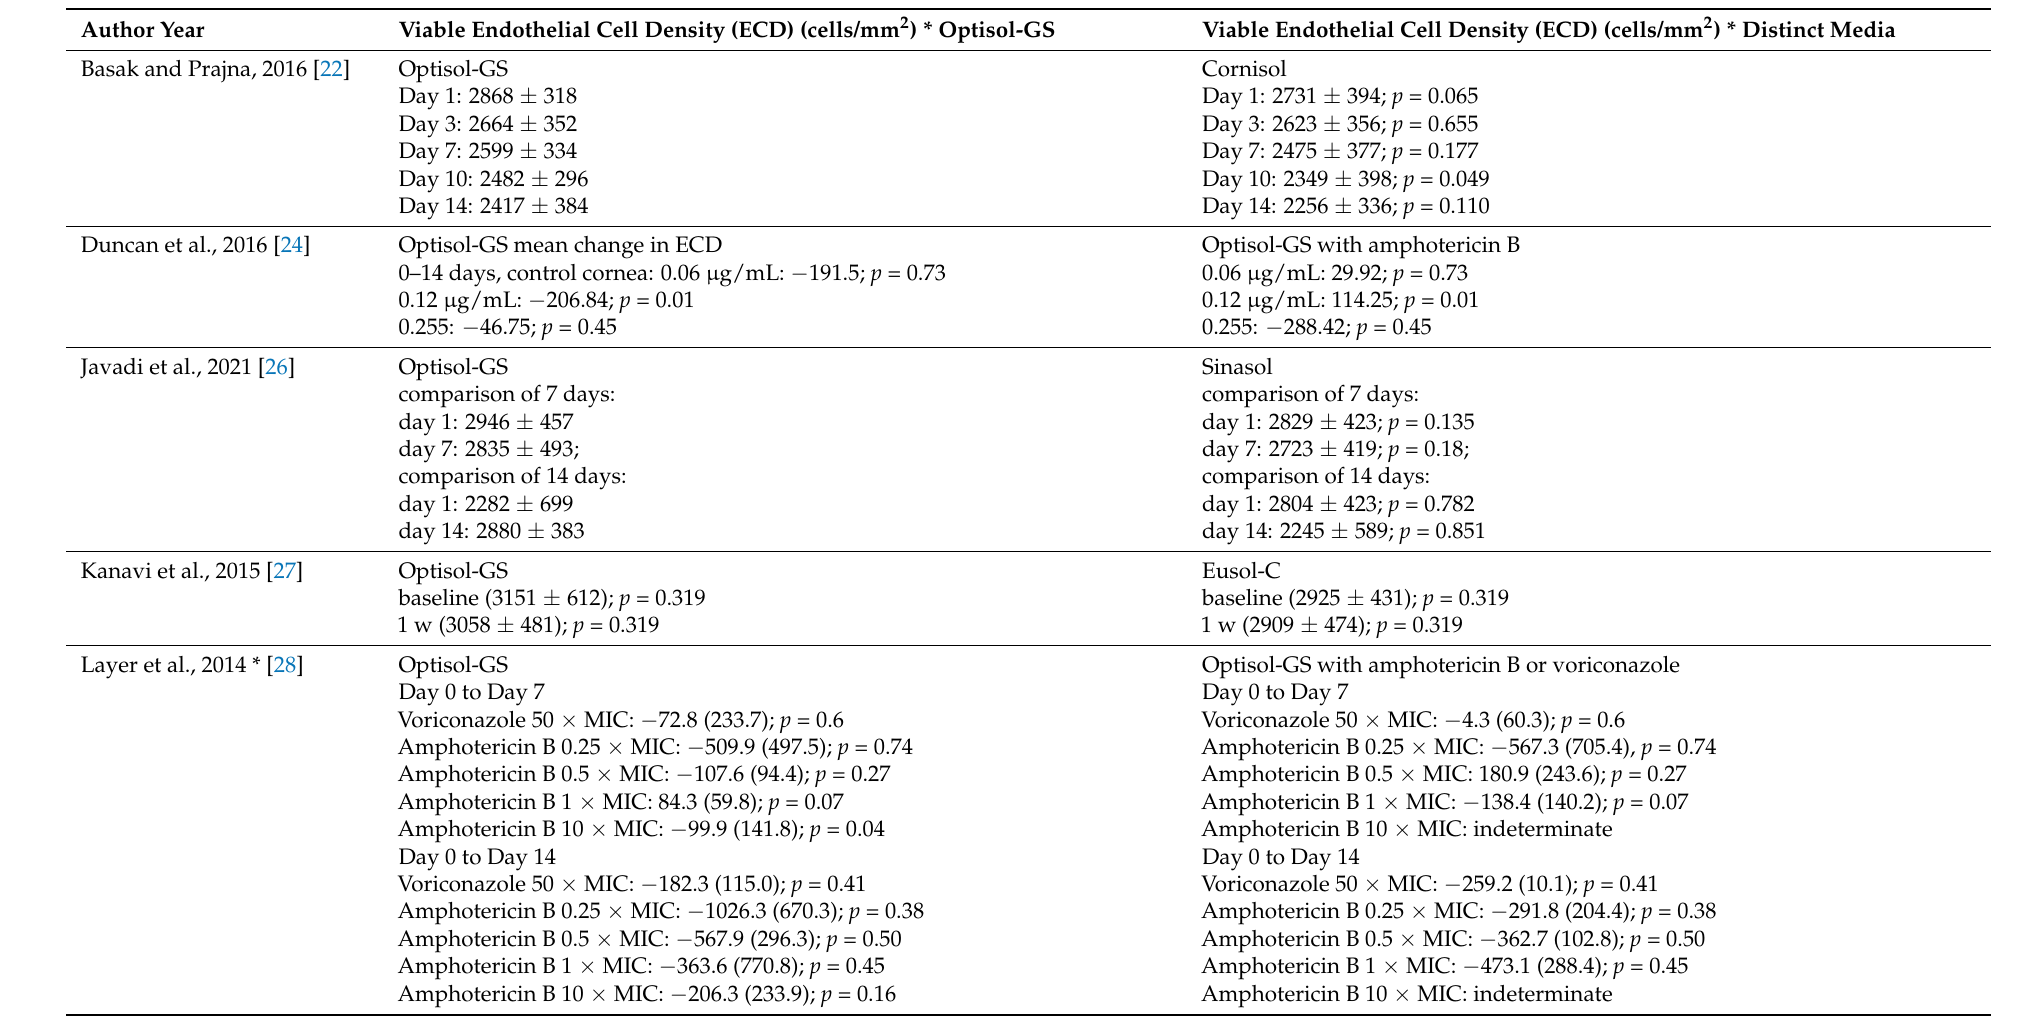
Table 7. Extracted results for endothelial cell